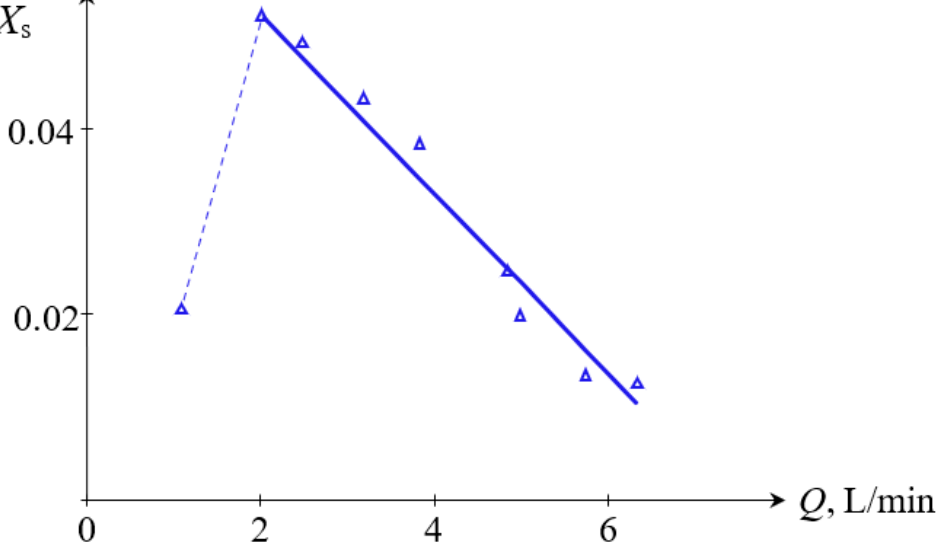
Figure 11. Dependence of the segregation index X s on the total flow rate Q 2 (L/min) for liquids supplied to two upper tangential branch pipes (TU1, TU2). Points—experimental data, line—result of approximation for Q ≥ 2 L/min: X s = kQ + b , where k = – 0.011, b = 0.078.